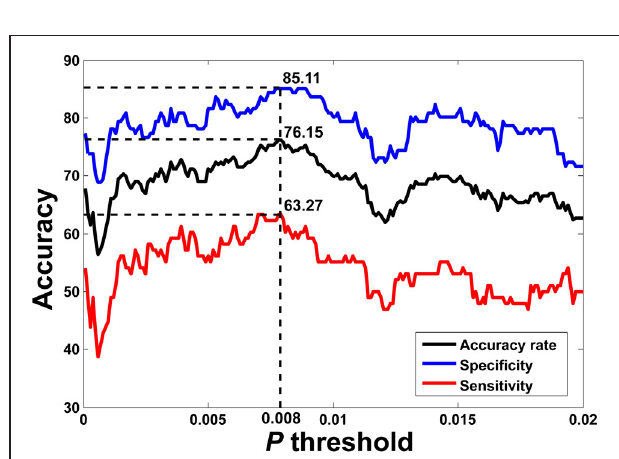
FIGURE 6 | LOOCV prediction accuracy of classifying ADHD patients from controls with respect to different p -value thresholds in feature selection. Corresponding sensitivity and specificity are also plotted. It can be seen that for a wide range of p -value thresholds in selecting features for SVM, we can achieve more than 70% of accuracy in predictions. The best accuracy (76.15%) is achieved when p -value threshold is